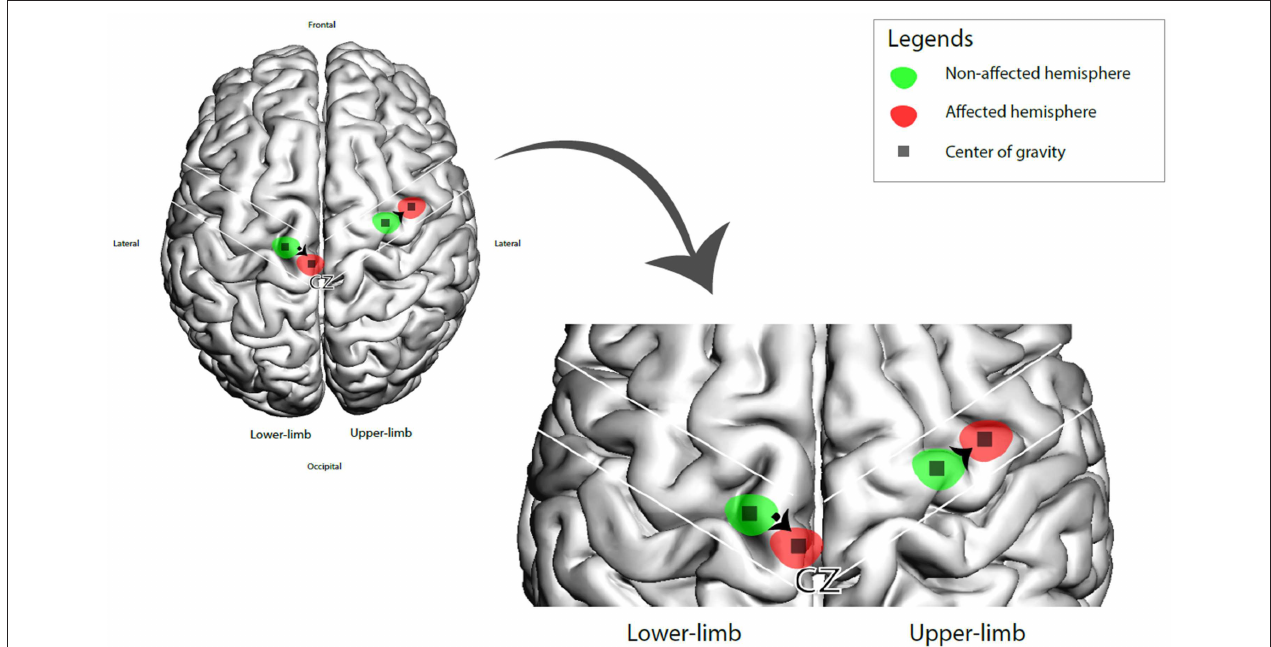
FIGURE 3 | 3D brain representation of the CoG shift (affected vs. intact hemisphere) in upper and lower amputee patients.